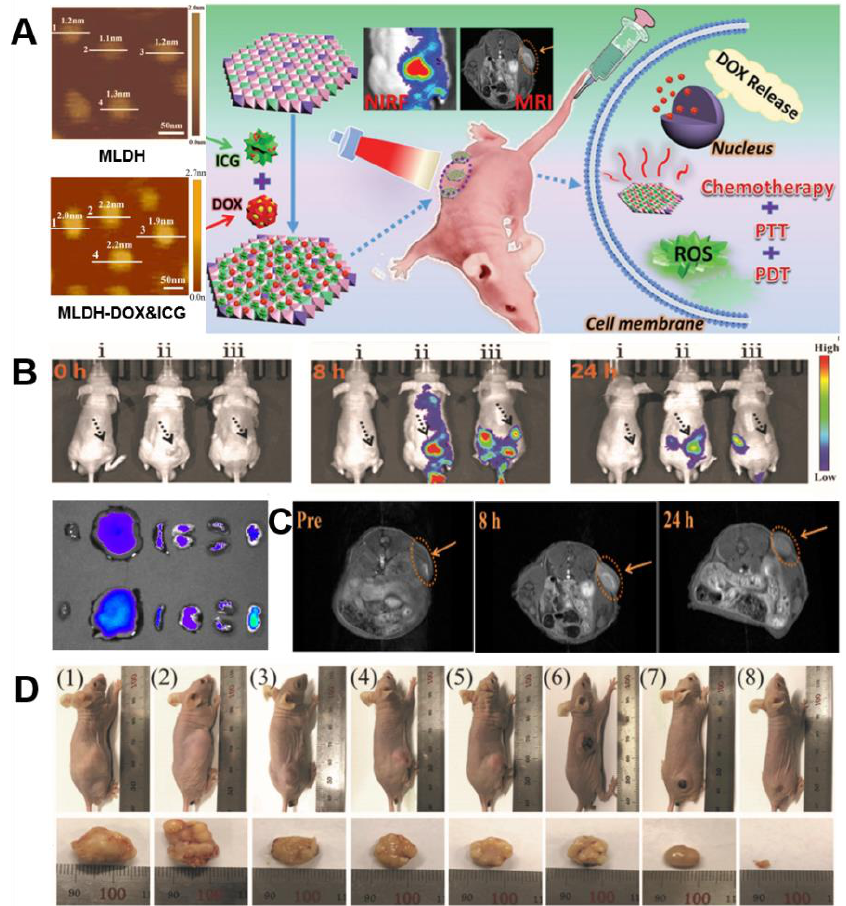
Figure 10. ( A ) AFM images of Gd-MLDH and Gd-MLDH-DOX&ICG nanosheets (left), schematic illustration for MLDH-based versatile platform that can be utilized for dual modal imaging including NIRF and MR imaging with the synergistic chemo-/PT/PD combination therapy (right). ( B ) In vivo fluorescence imaging of nude mice bearing HepG2 tumors at different time points after i.v. injection of i : saline, ii : MLDH-DOX&ICG, and iii : DOX&ICG (tumors are pointed out by the black arrows) and NIRF images of tumor and different organs after i.v. injection of DOX&ICG (top) and MLDH-DOX&ICG (bottom) at 24 h (respectively heart, liver, spleen, lung, kidney, tumor, from left to right). ( C ) In vivo T 1 -weighted MR images at different time points after i.v. injection of MLDH-DOX&ICG (tumor locations are indicated by the orange arrows). ( D ) Digital photographs of the mice on day 14 after various treatments and corresponding excised tumors (respectively from (1) to (8): saline, MLDH nanosheets, DOX&ICG, MLDH-DOX&ICG, MLDH-DOX with irradiation, DOX&ICG with irradiation, MLDH-ICG with irradiation, and MLDH-DOX&ICG with irradiation), reproduced from [57], with permission from WILEY-VCH Verlag GmbH & Co. KGaA, 2018. It was confirmed that diagnosis for tumor can be performed noninvasively using in vivo dual